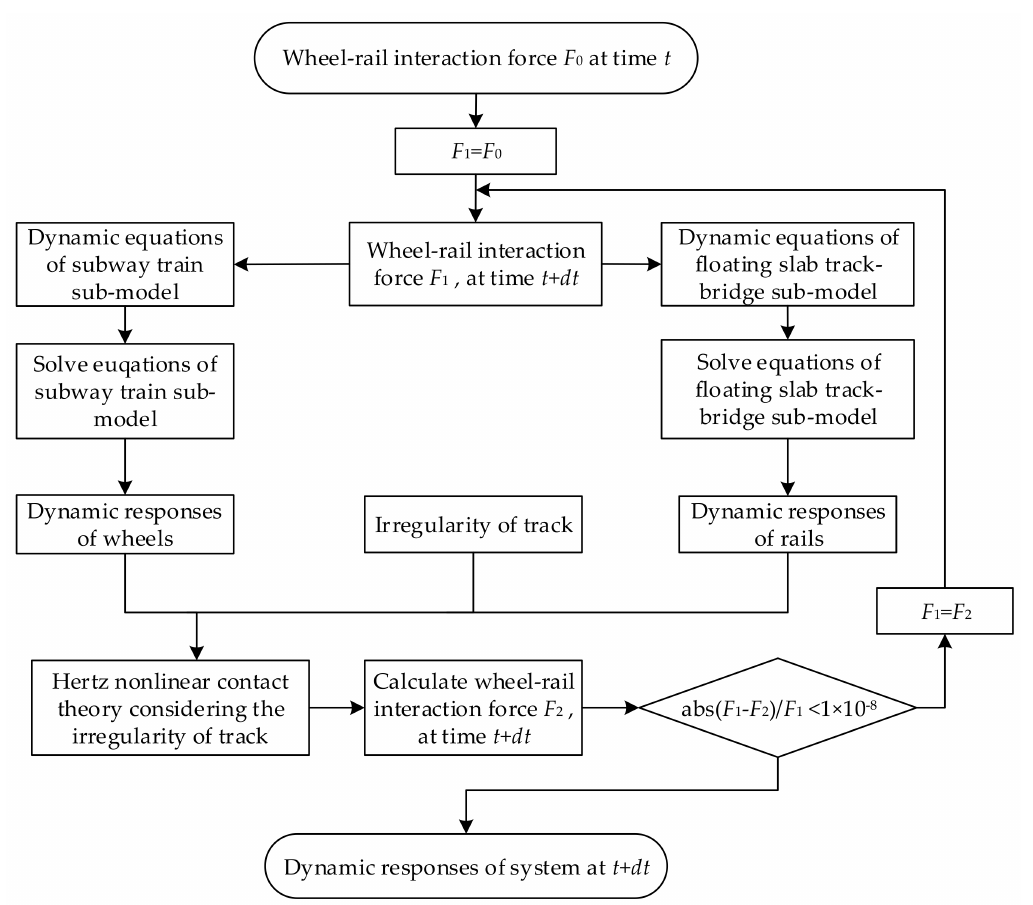
Figure 7. Flow-chart of the iteration